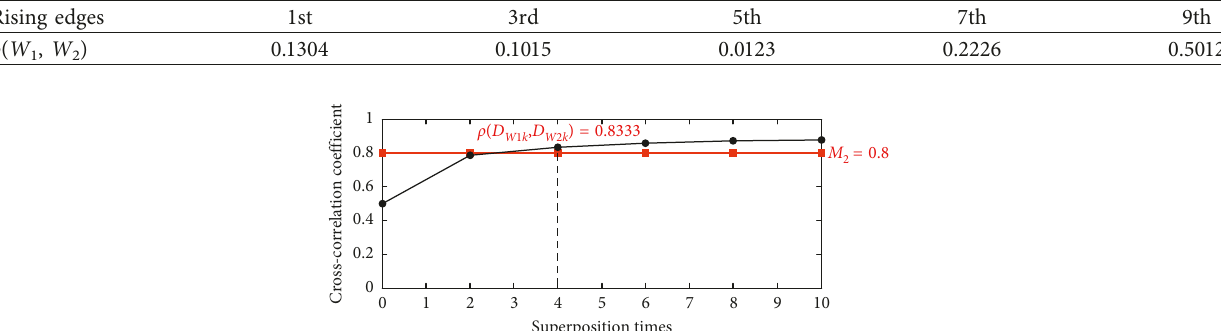
Figure 15: ρ ( D W 1 k , D W 2 k ) under different superposition numbers. ρ ( D W 10 , D W 20 ) represents ρ ( W 1 , W 2 ).